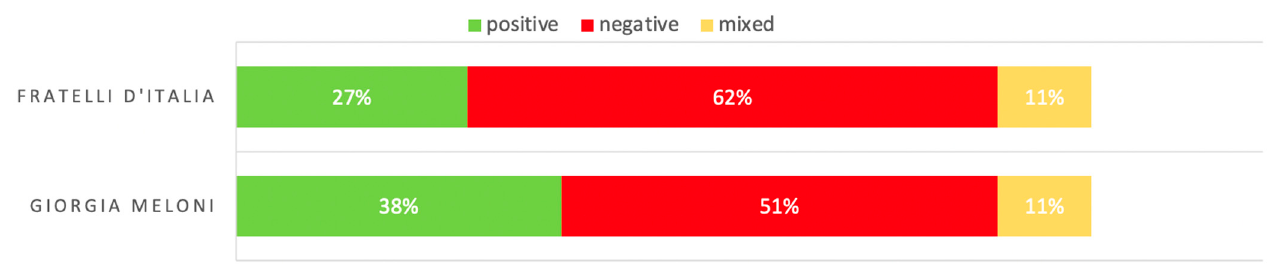
Figure 8. Automatic scanning mood by the tool FanPage Karma. Reference period: May 2021. The last two months of this journey backwards closes with Giorgia Meloni surpassing the medial step of the 35% rating that she takes home after having sown in winter (in May the rating is 38% and in June it is 37%) and is also consecrated with the 20% medal, the new frontier that SWG attributes to Fratelli d’Italia in the Italians’ voting intentions. The preponderant aspect that is more solidified in the latest election campaign is the pop aspect of the leader of Fratelli d’Italia. There are those who relate popular politics with the phenomenon of populism and consider pop politics and celebrity politics as tools for the popularisation of political leadership and found in populist phenomena (Mazzoleni 2004). Cas Mudde (2004) spoke of the ‘Populist Zeitgeist’, i.e., the existence of a certain ‘soft’ populism in many mature democracies and often also exhibited by leaders who do not pursue populist policies. Giorgia Meloni’s populist style also seems to fall into this casuistry, as the powers in government, the ruling party, and the media are personalised and identified in one person. The recently concluded election campaign has confirmed and to some extent armoured everything we have highlighted so far. Let us start from these data.